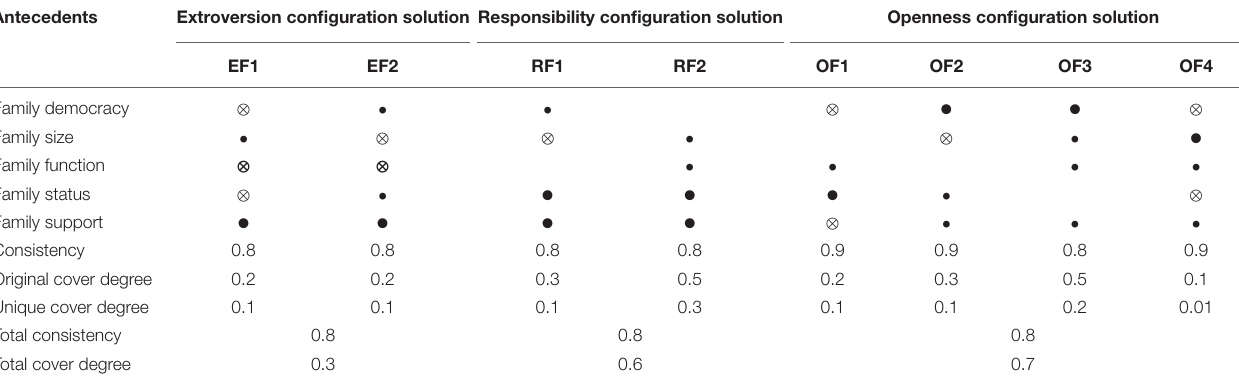
FIGURE 2 | Configuration matching model. TABLE 5 | Matching analysis of family experience and high original innovation